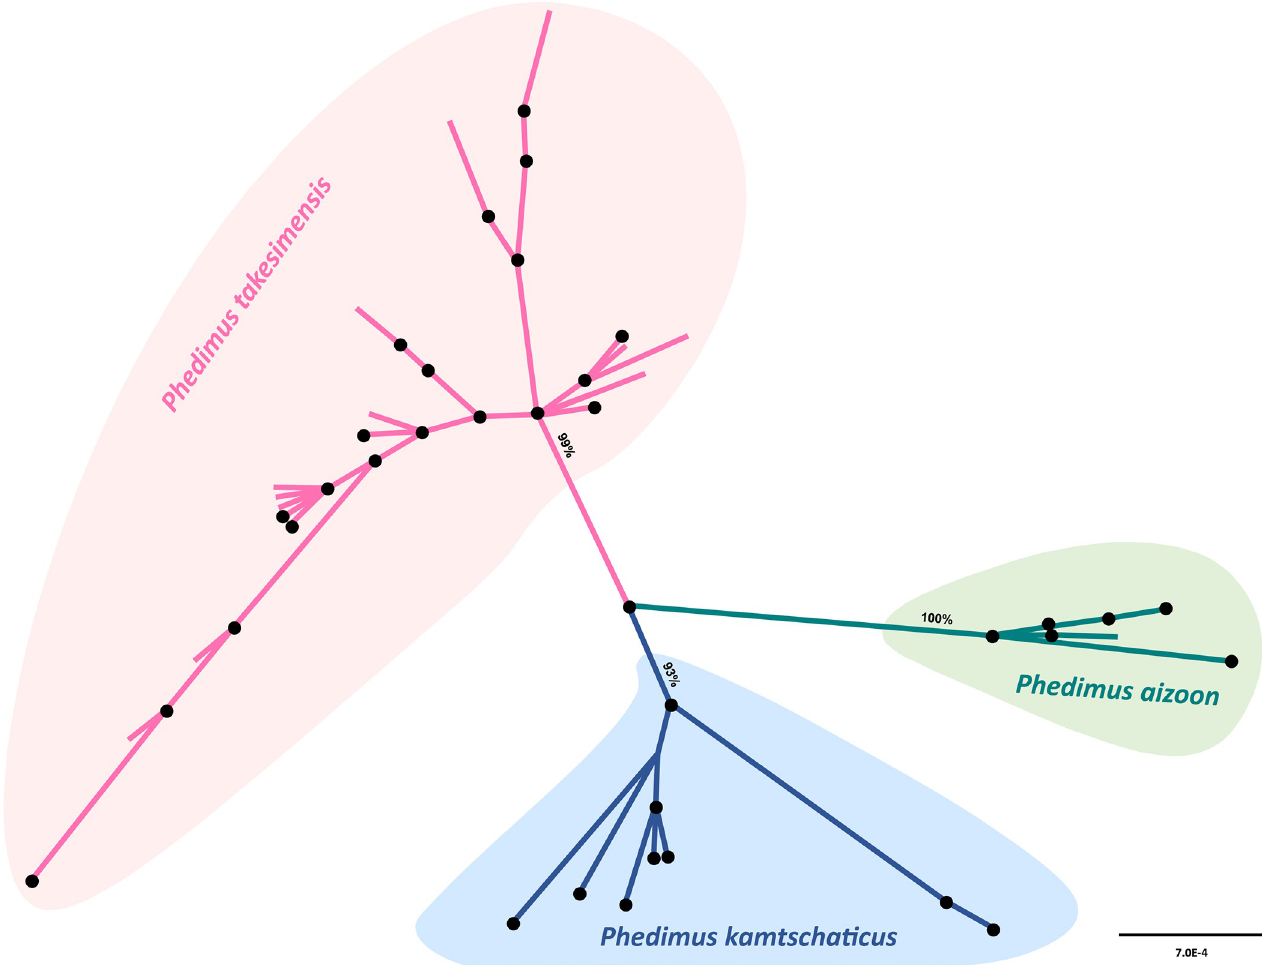
Fig 4. Unrooted maximum likelihood tree of insular derived Phedimus takesimensis and two continental progenitor species, P . kamtschaticus and P . aizoon . Bootstrap supports for the three species are